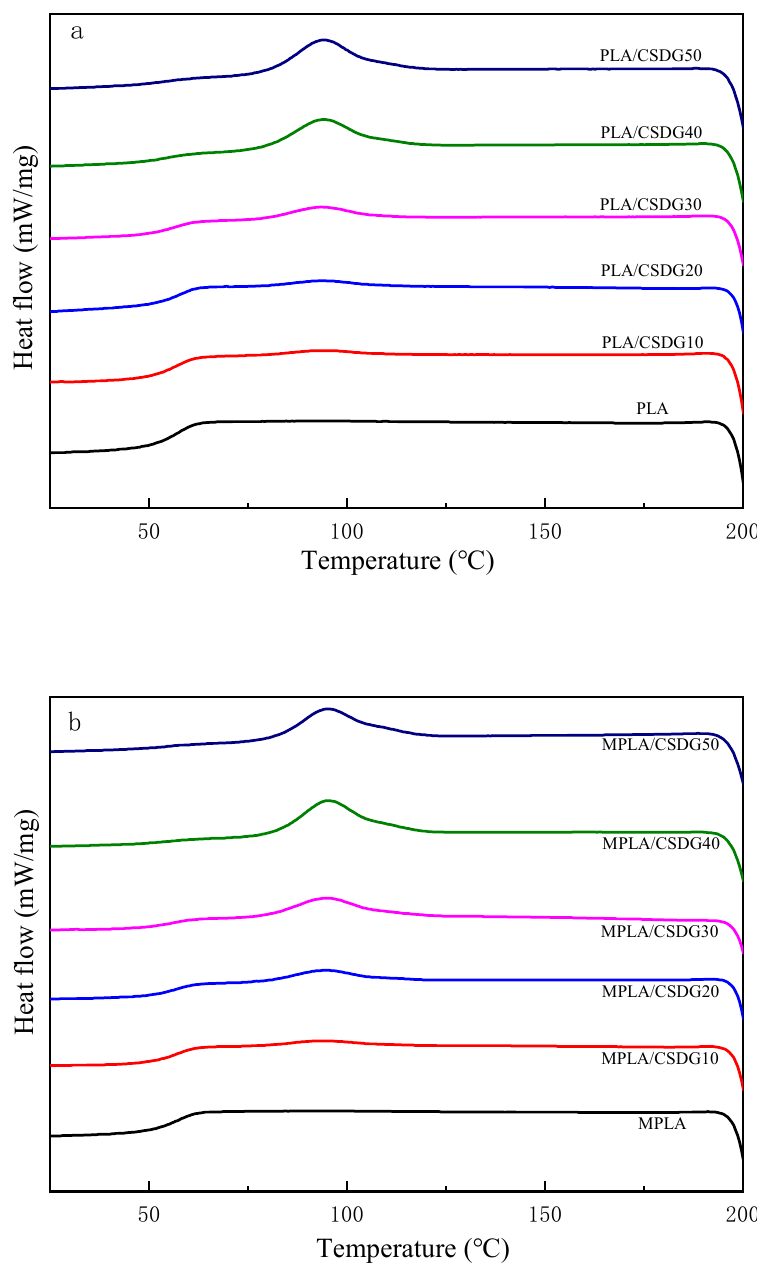
Figure 6. Cooling curves: ( a ) PLA/CSDG; ( b ) MPLA/CSDG.